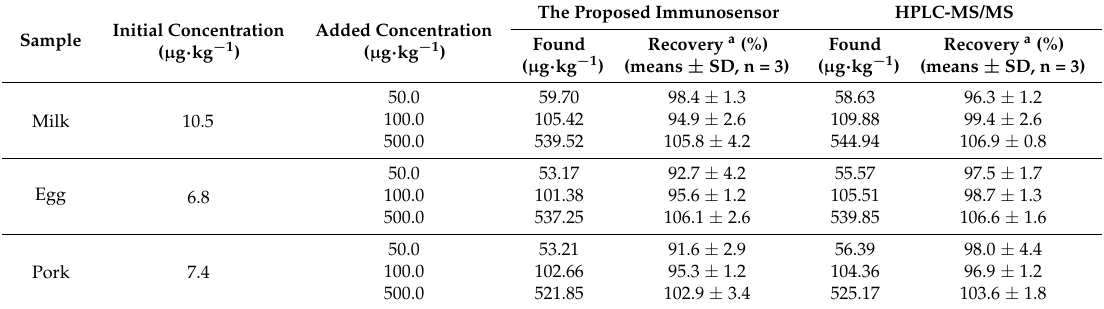
Table 2. Comparing of the results with the proposed immunosensor and the HPLC-MS/MS method in the detection of norfloxacin in daily animal-derived